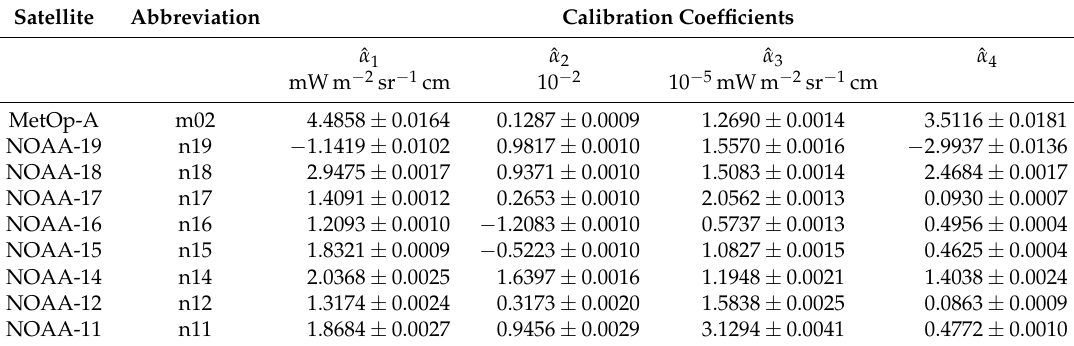
Table 3. Values of harmonised calibration